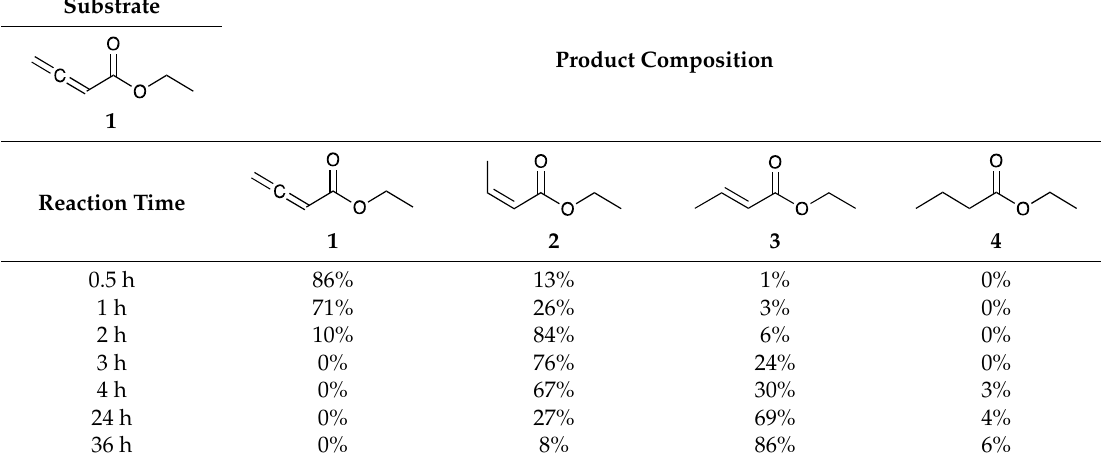
Table 1. Catalytic reaction of ethyl buta-2,3-dienoate 1 a .